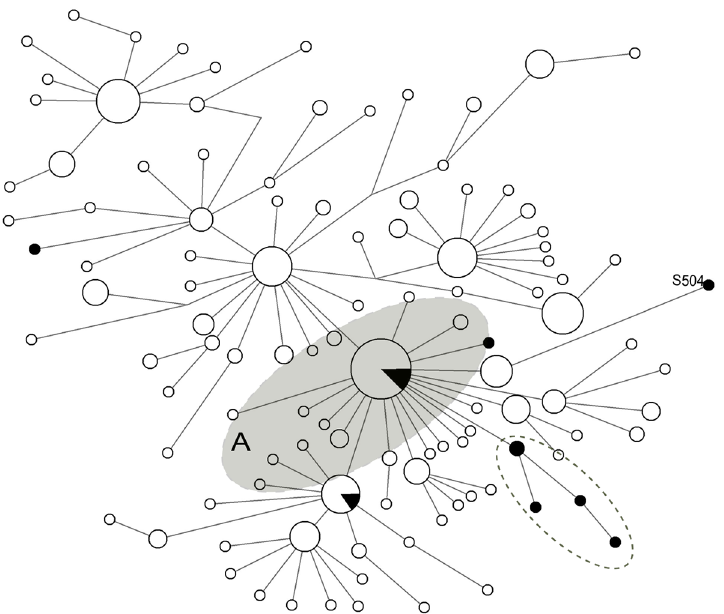
Fig 4. Median-joining network of dog specimens for the mitochondrial DNA control region. Black circles indicate samples from our study. Sequences analyzed in the network span nucleotide positions 15547 – 15705. Clade A is highlighted in light gray and the Duvanny Yar sample S504 is noted in the network. The bottom-right cluster highlighted with a dashed line circle includes the samples S805, S806, S809, and